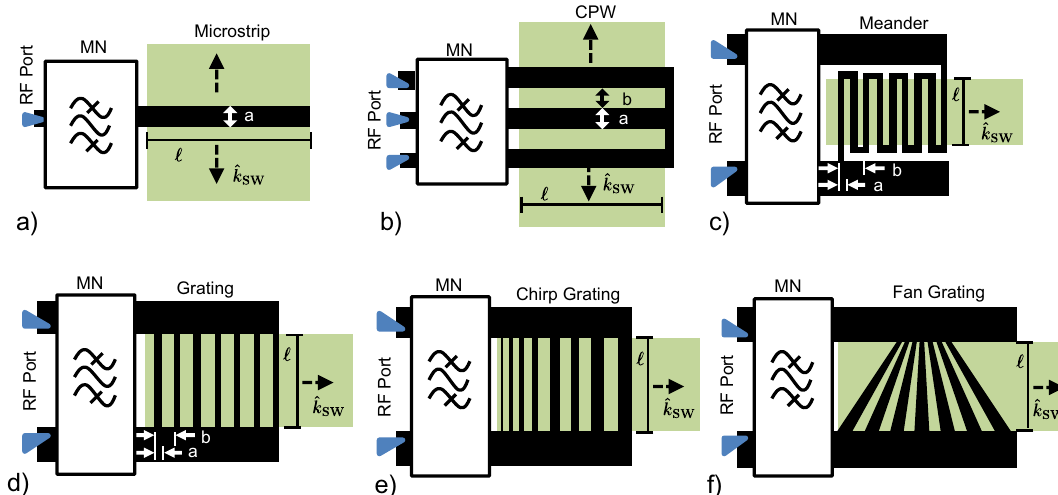
Figure 3. Various classes of transducers. ( a ) Narrow-band single-conductor transducer (microstrip); ( b ) narrow-band multi-conductor transducer (CPW); ( c , d ) multi-conductor transmission-line transducers (meander and grating, respectively); ( e , f ) wide-band multi-conductor transducers for chirp and fan gratings,